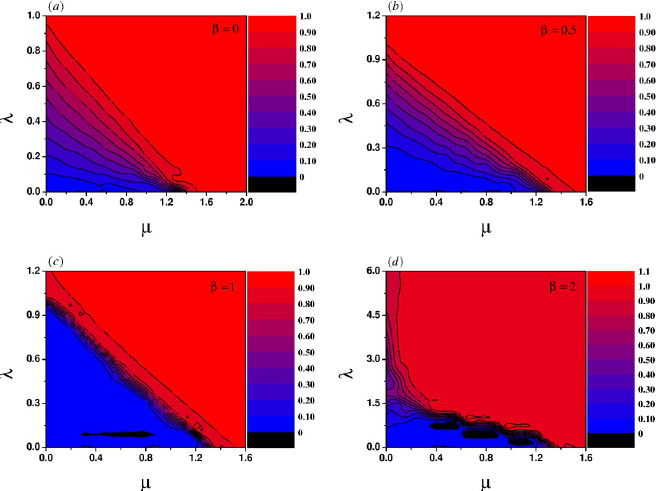
Fig 8. Order parameter of the upper layer is described by chromaticity in the λ − μ parameter plane. The chromaticity ranges from 0 (black) to 1 (red). The greater its value, the higher the degree of phase coherence. The values of β in each panel are (a) β = 0, (b) β = 0.5, (c) β = 1, (d) β = 2, respectively.